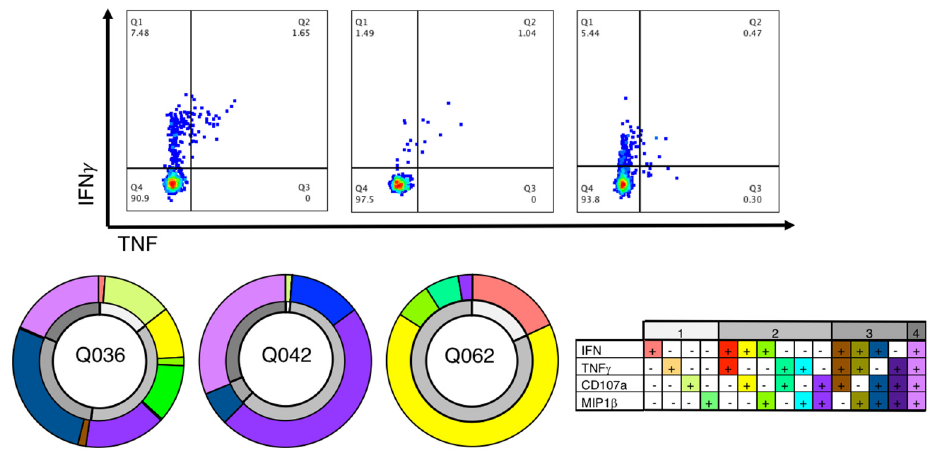
Figure 1. Polyfunctional response from YLQ-specific CD8+ T cells. The top panels are representative FACs plots for each donor (Q036, Q042 and Q062) showing IFN γ and TNF production from CD8+ T cells against the YLQ peptide. The bottom panels represent the polyfunctionality level of CD8+ T cells for the same COVID-19 recovered donors as the top panel. The outside ring, in colour, shows the % of cytokine combinations produced by CD8+ T cells, while the inner ring (in grey) represents the number of functions produced by CD8+ T cells. The keys for each colour are in the bottom-right table.